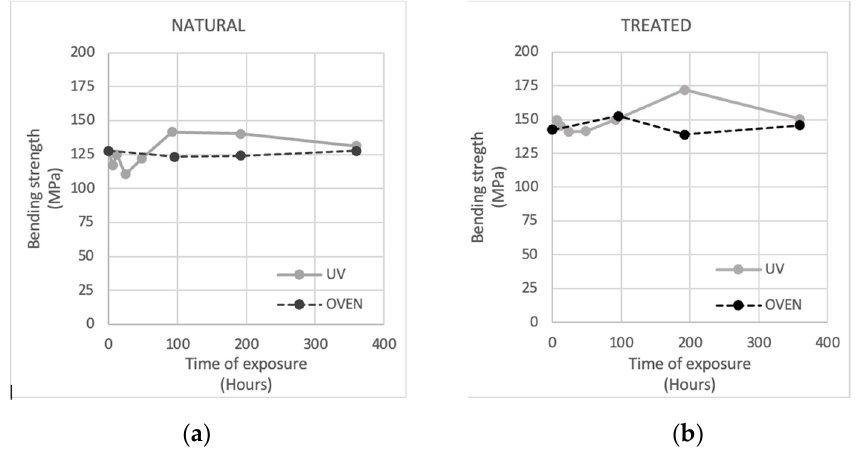
Figure 8. Effect on bending strength of the exposure to the temperature of 40 °C compared to the exposure to UV rays. ( a ) Natural case; ( b ) Treated case. Table 2. Difference in bending strength between samples exposed to UV rays and those exposed to temperature for three different lengths of exposure.